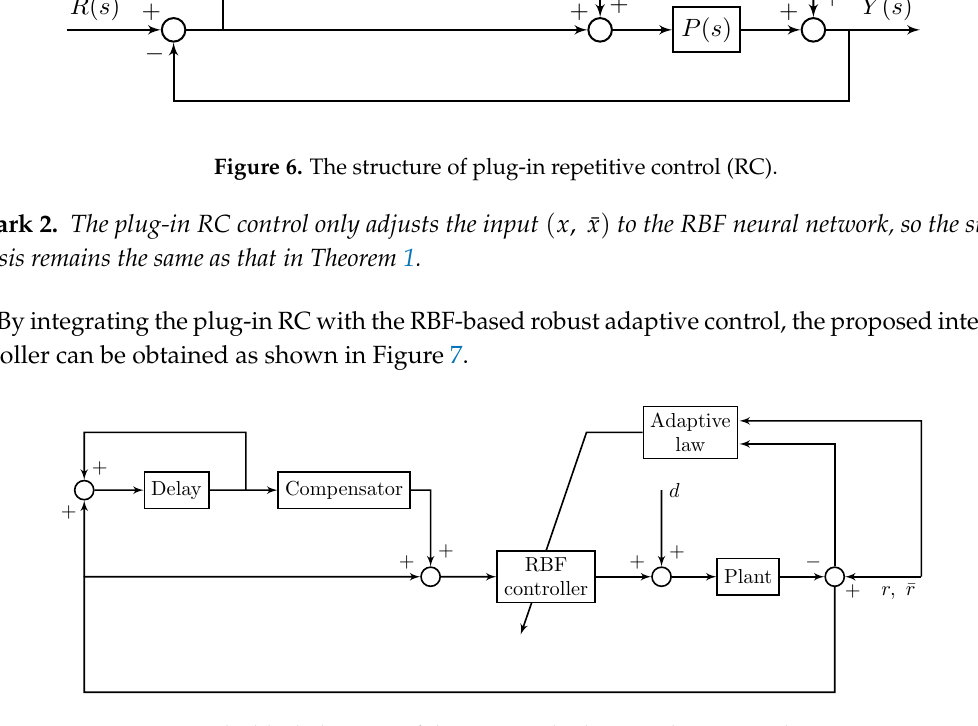
Figure 7. The block diagram of the proposed robust tracking control